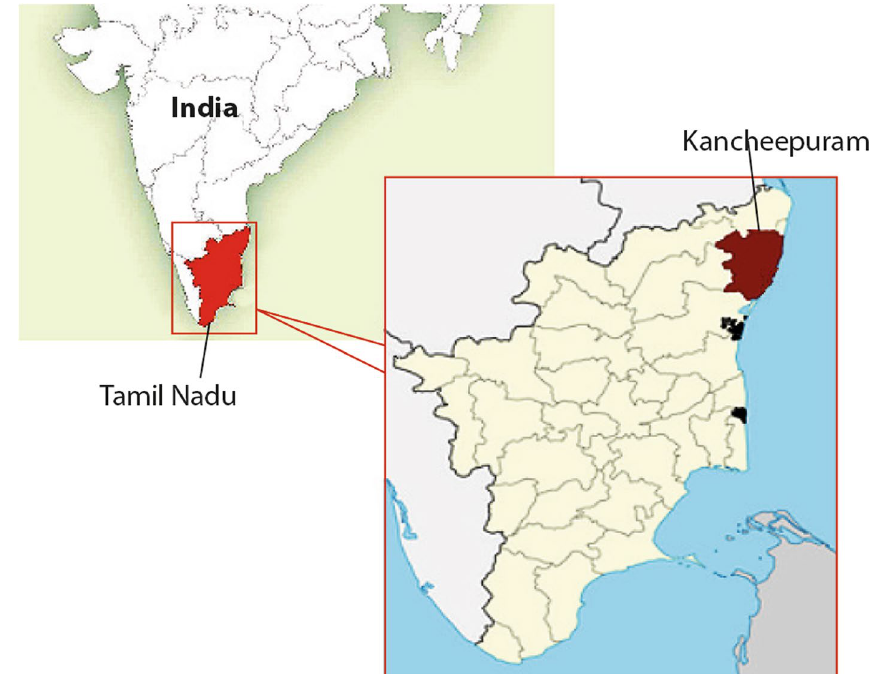
Fig. 1 Map showing location of Kanchipuram in India (Source: the author, based on the map from Wikimedia https:// commo ns. wikim edia. org/ wiki/ File: Kanch ipuram_ distr ict_ Tamil_ Nadu.